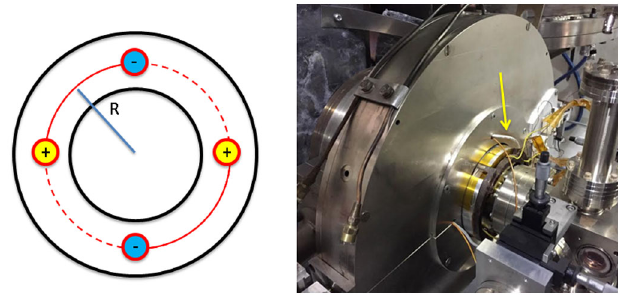
FIG. 5. Wiring of the correction quadrupole magnet, and photo of the wiring as installed. The single turn of wire is indicated with an arrow.